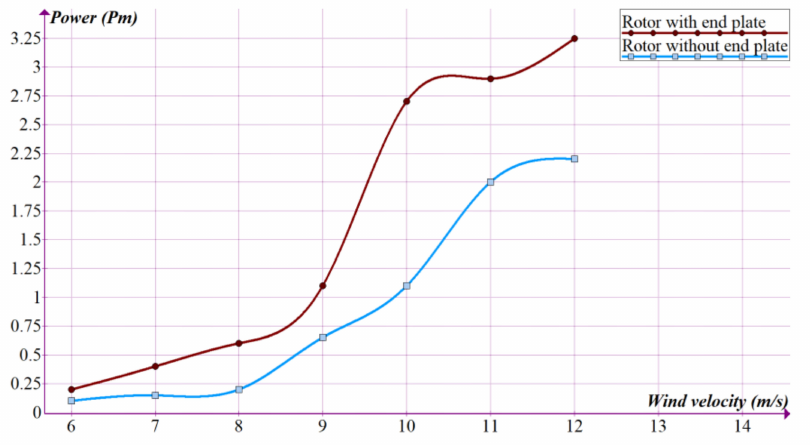
Figure 9. Power values for rotor with and without end plates